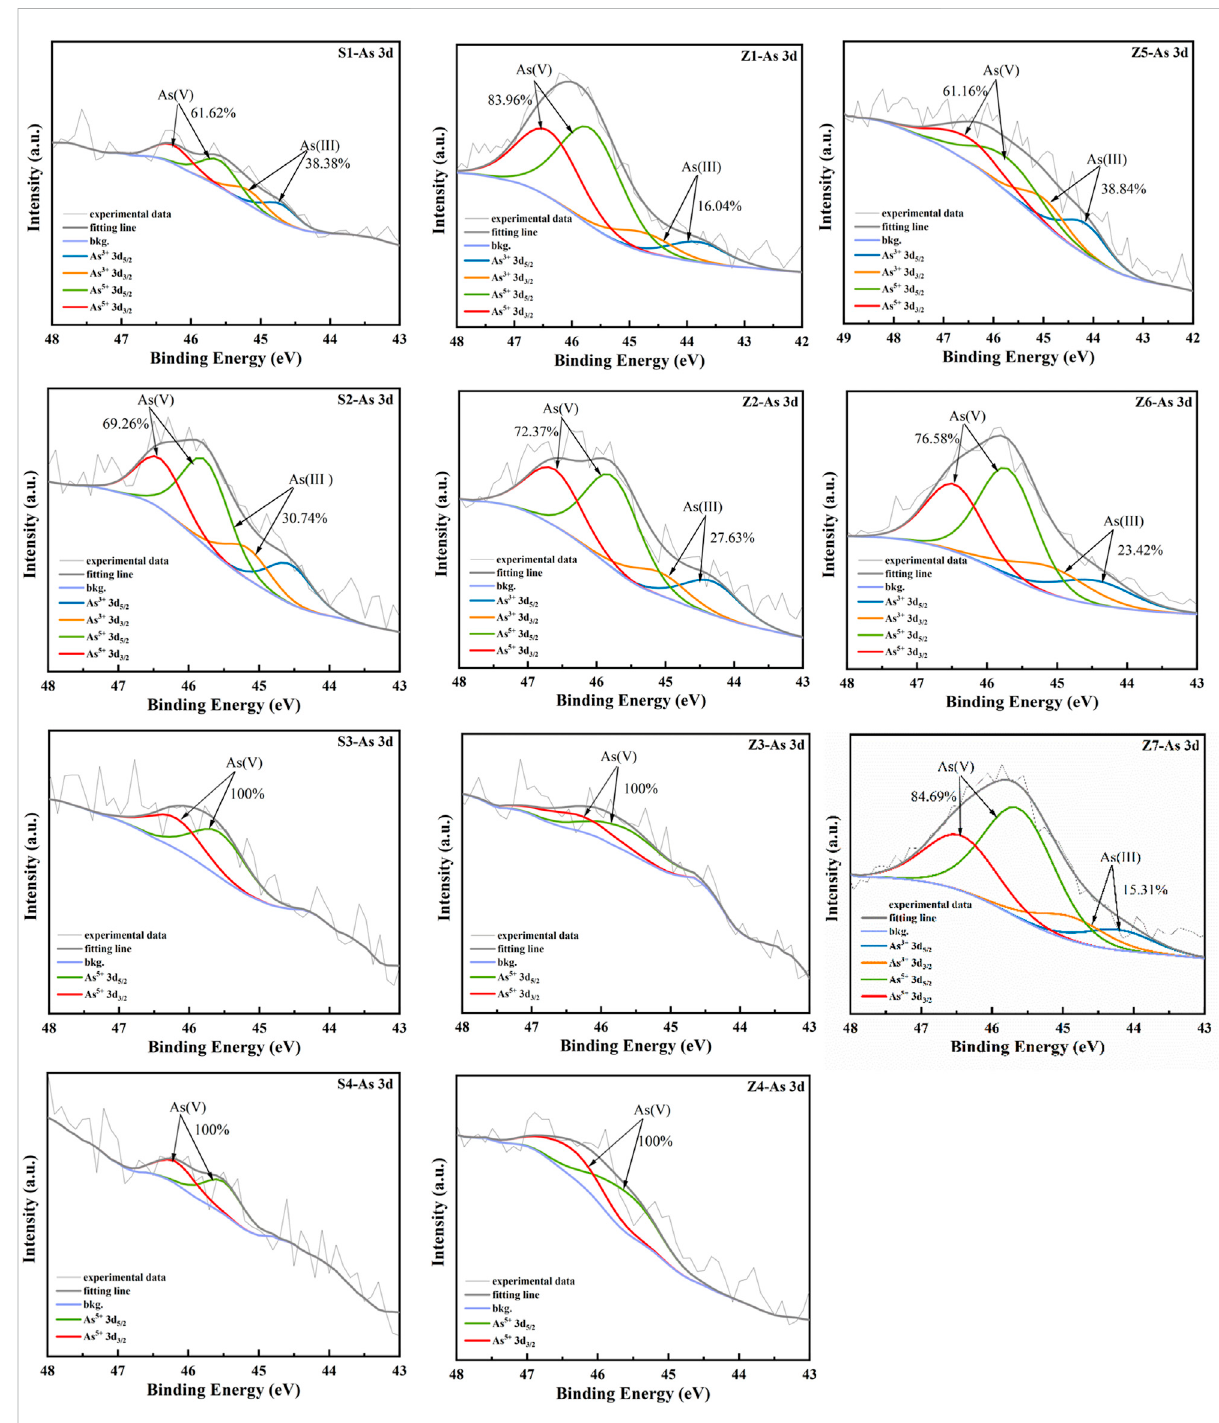
FIGURE 7 The As 3d XPS spectra of soils (SI – S4), slags (Z1 – Z6), and sludge (Z7).